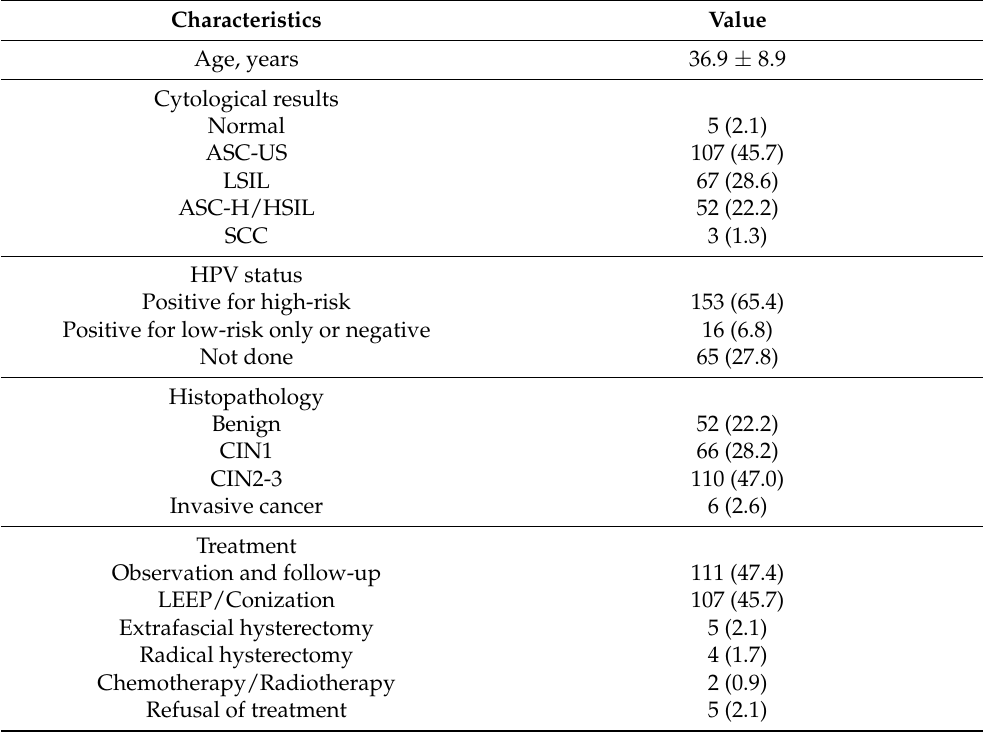
Table 1. Clinical Characteristics of Study